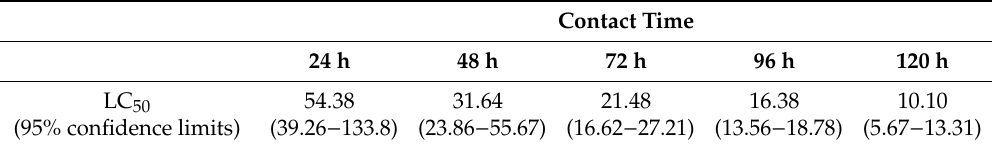
Table 3. Median lethal concentrations (LC 50 , µ L / mL, and 95% confidence limits) of Launaea taraxacifolia essential oil against Sitophilus oryzae